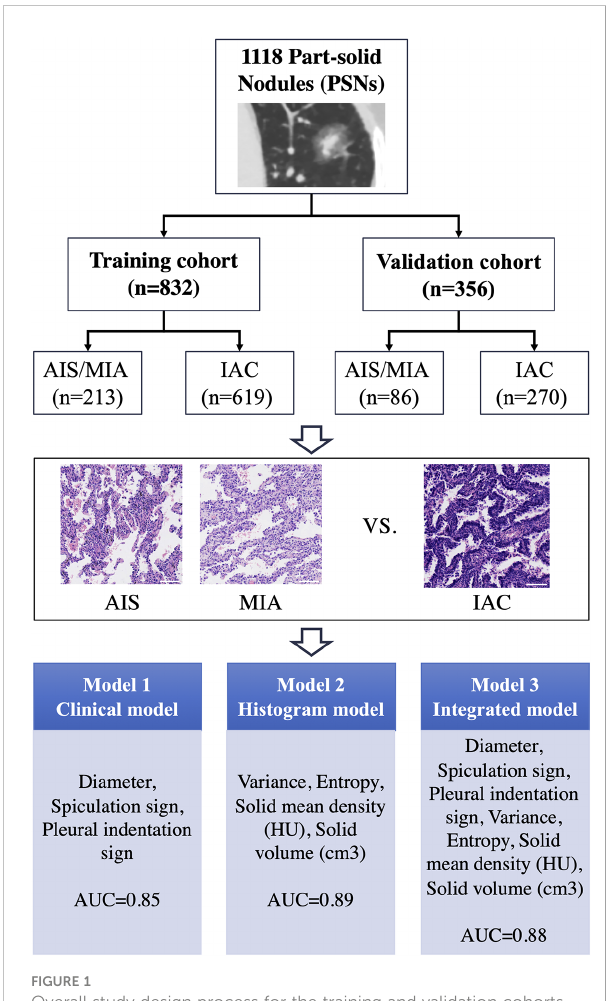
FIGURE 1 Overall study design process for the training and validation cohorts and prediction performance by each model for predicting invasive adenocarcinoma (IAC). AIS, adenocarcinoma in situ ; MIA, minimally invasive adenocarcinoma; AUC, area under the ROC curve. The length of the ruler in the fi gure is 10